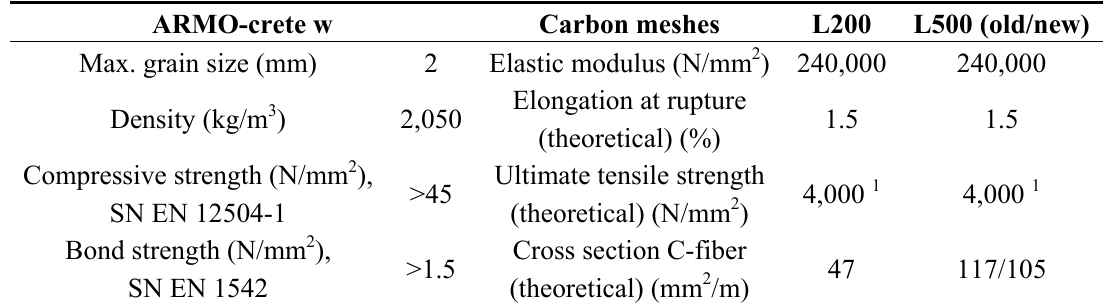
Table 1. Material properties of ARMO-crete w and used carbon meshes according to manufacturer [12].